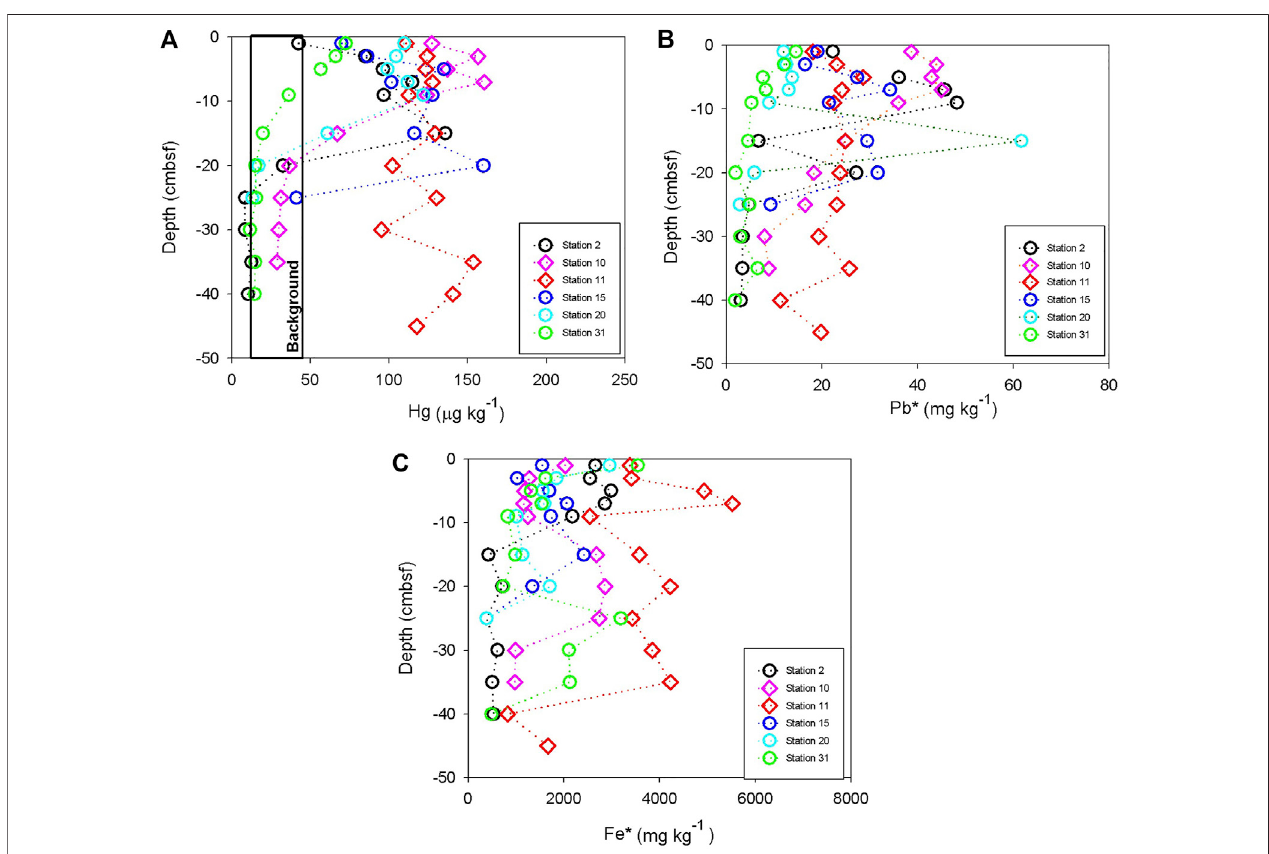
FIGURE 9 | Vertical pro fi les of the contents of total Hg, (A) , including the background level for Baltic Sea (Leipe et al., 2013), and Pb (B) and Fe (C) of sediment cores from WB. *HCl extractable fraction.